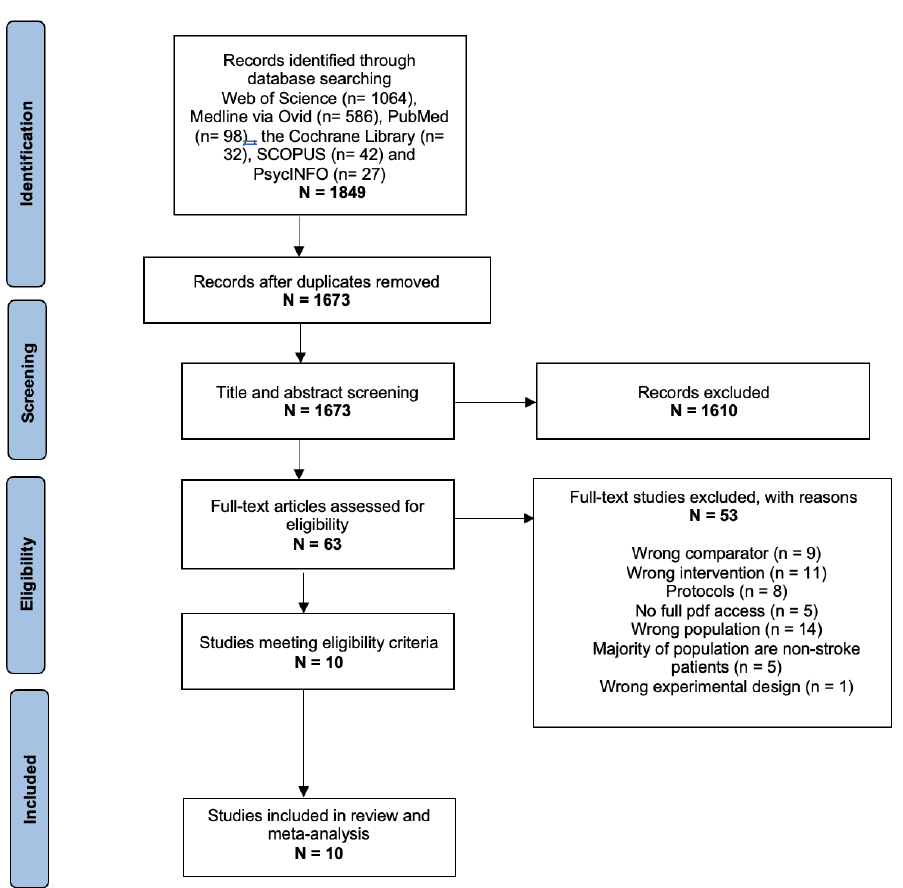
Figure 1. PRISMA flow diagram of systematic search, inclusion, and exclusion of studies adapted from Moher et al. [42].